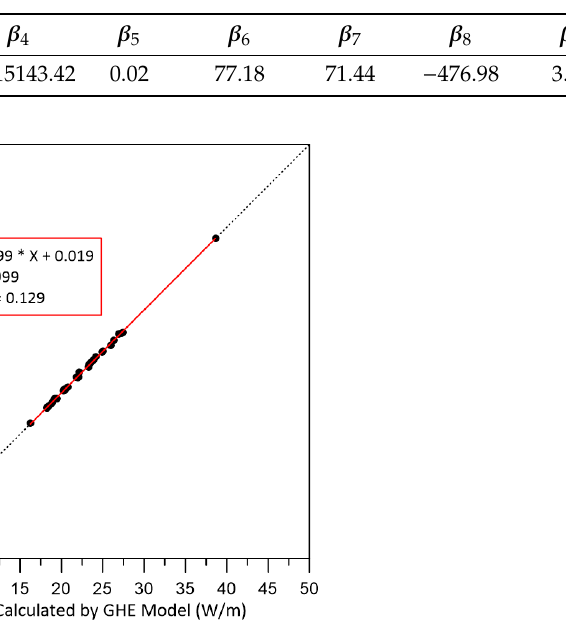
Figure 10. Comparison of the heat exchange rate calculated by the GHE models with that estimated by the RSM in the Sendai Plain. HER, GHE, and RSM denote the heat exchange rate, ground heat exchanger, and response surface methodology, respectively. Table 4. Relational data between the three parameters and HER at 33 GHE models. HER calculated by the GHE model is based on Kaneko et al. [21].